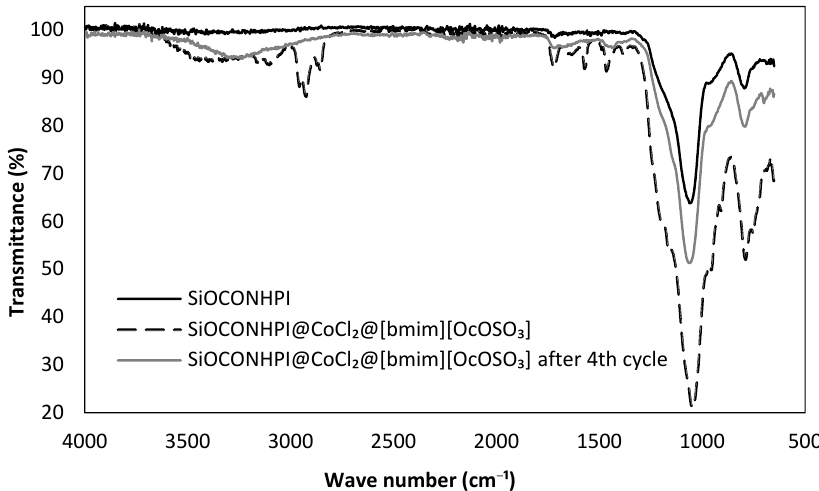
Figure 7. FT-IR spectra of SiOCONHPI, SiOCONHPI@CoCl 2 @[bmim][OcOSO 3 ] and SiOCONHPI@CoCl 2 @[bmim][OcOSO 3 ] after the fourth cycle.